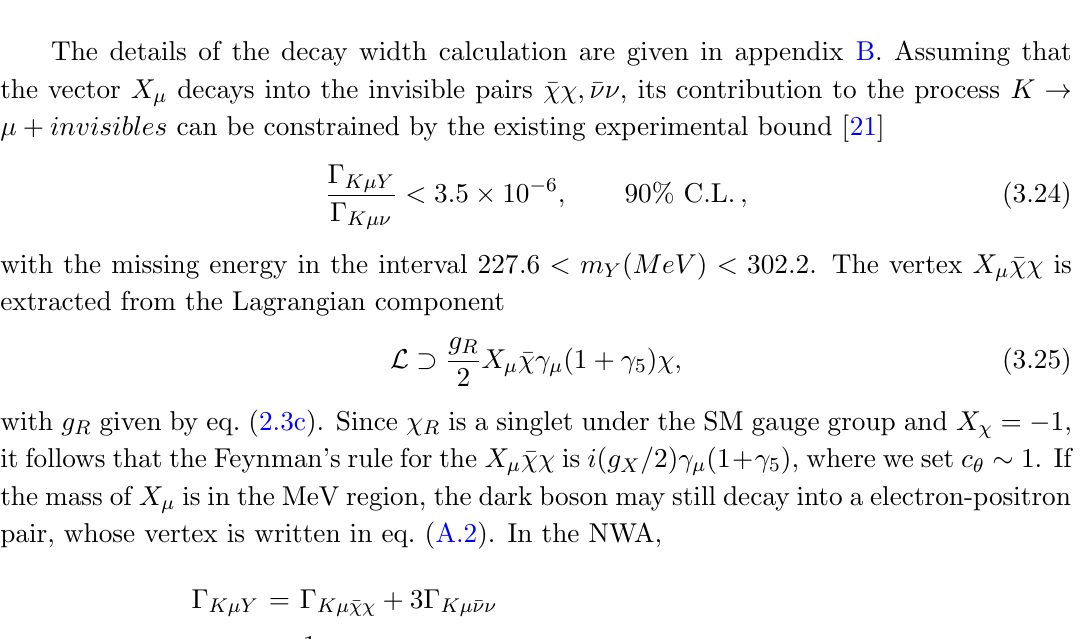
Figure 2 . For m X < 2 m (cid:22) the boson X (cid:22) has (cid:12)ve directly decay modes, l = e; (cid:31); (cid:23)